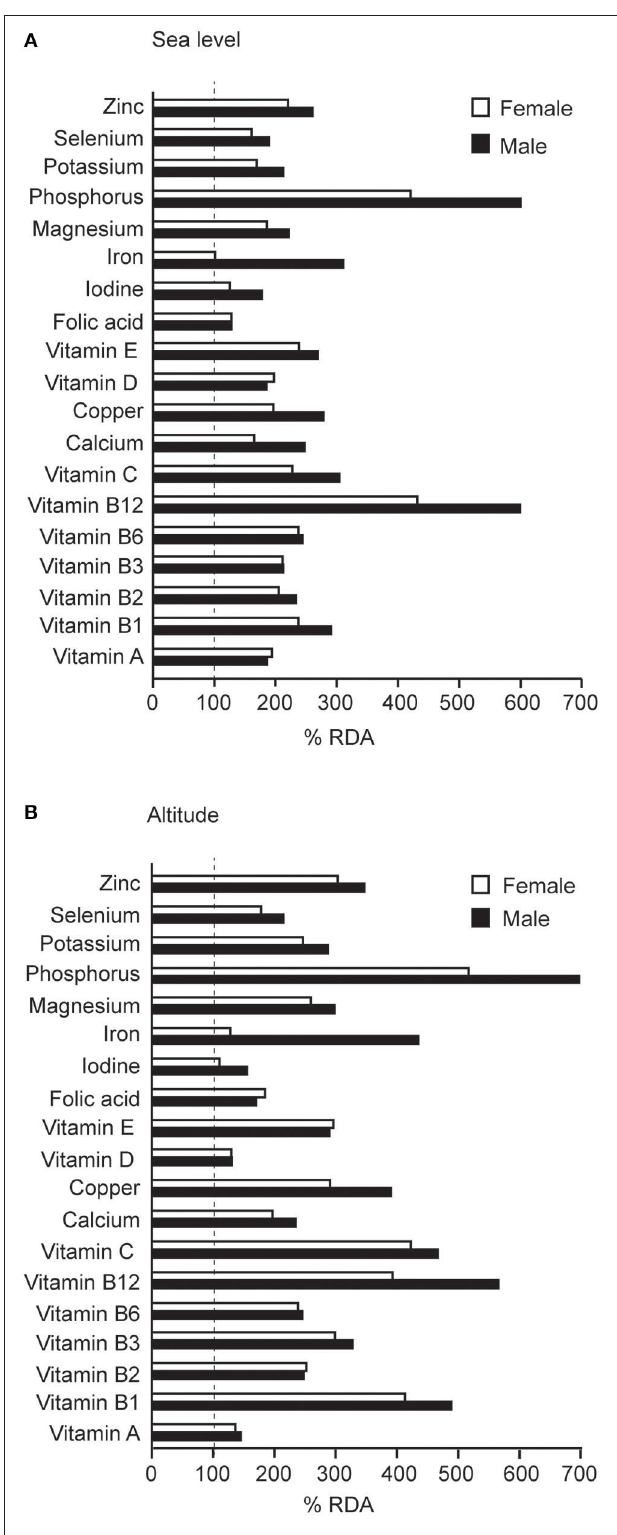
FIGURE 5 | Mean daily intake of micronutrients before (sea level) (A) and during (altitude) (B) the 3-week altitude training camp as compared to recommended daily allowances (RDA) (dotted line) (Ministers NCo,